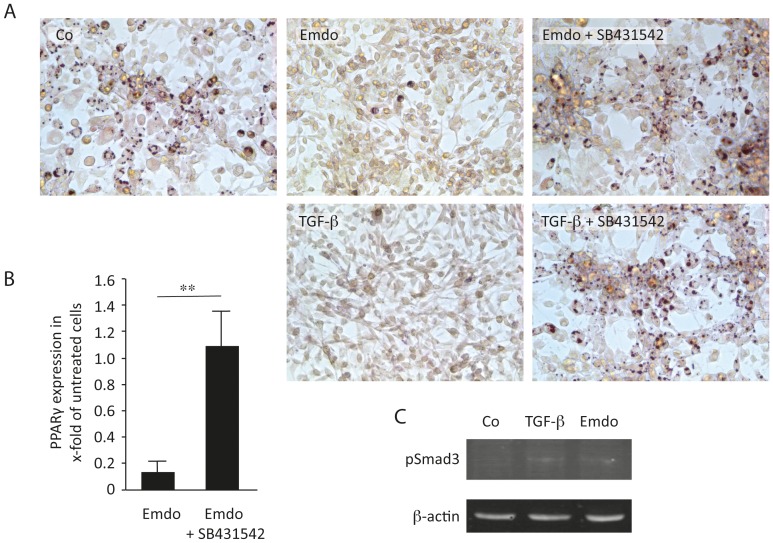
SB-431542, an inhibitor of TGF-β RI kinase activity, reversed the inhibitory effects of Emdogain®.The 3T3-L1 murine preadipocytes were incubated with basal adipogenesis-inducing medium containing rosiglitazone and indomethacin for 5 days in the presence of Emdogain® (100 µg/ml) or TGF-β (10 ng/ml) and a selective inhibitor of the TGF-β type I receptor SB-431542 (10 nM). (A) Lipid staining; (B) SB-431542 overcomes the blocking effect of Emdogain® on PPARγ expression; (C) Emdogain® and TGF-β increase phosphorylation of Smad3 in 3T3-L1 cells. **P<0.01%.